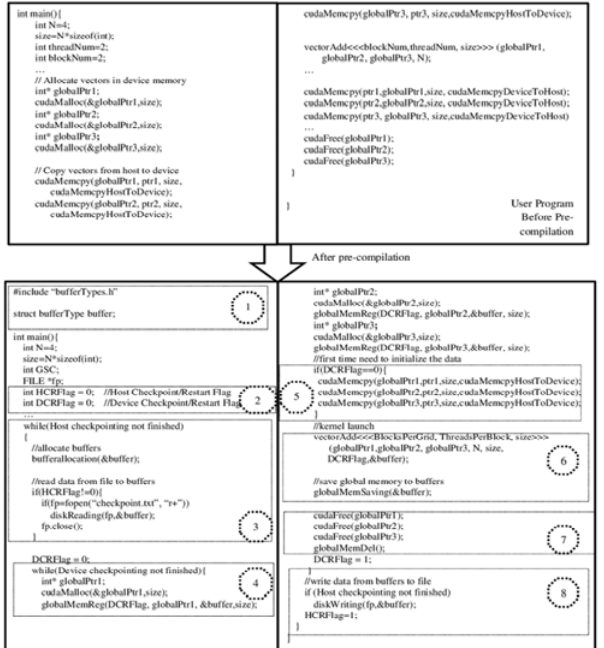
Fig. 3. An Example of Host Side